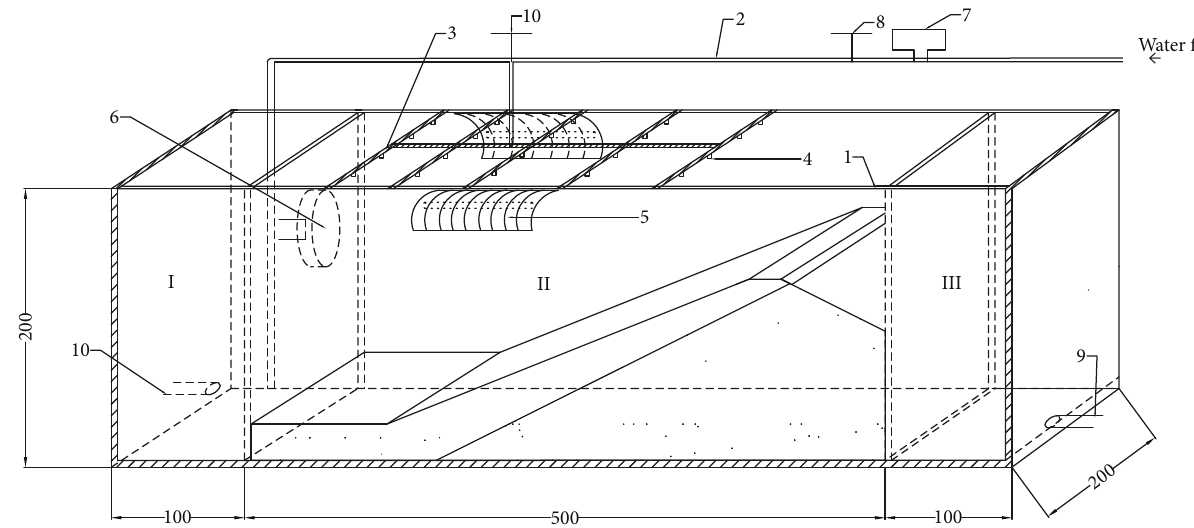
Figure 1: Model system (unit: cm). 1: tempered glass cover, 2: water pipe, 3: rain line, 4: atomization nozzle, 5: long arc xenon lamp, 6: fan, 7: booster lamp, 8: fl ow meter, 9: drain hole, and 10: rainfall/impound